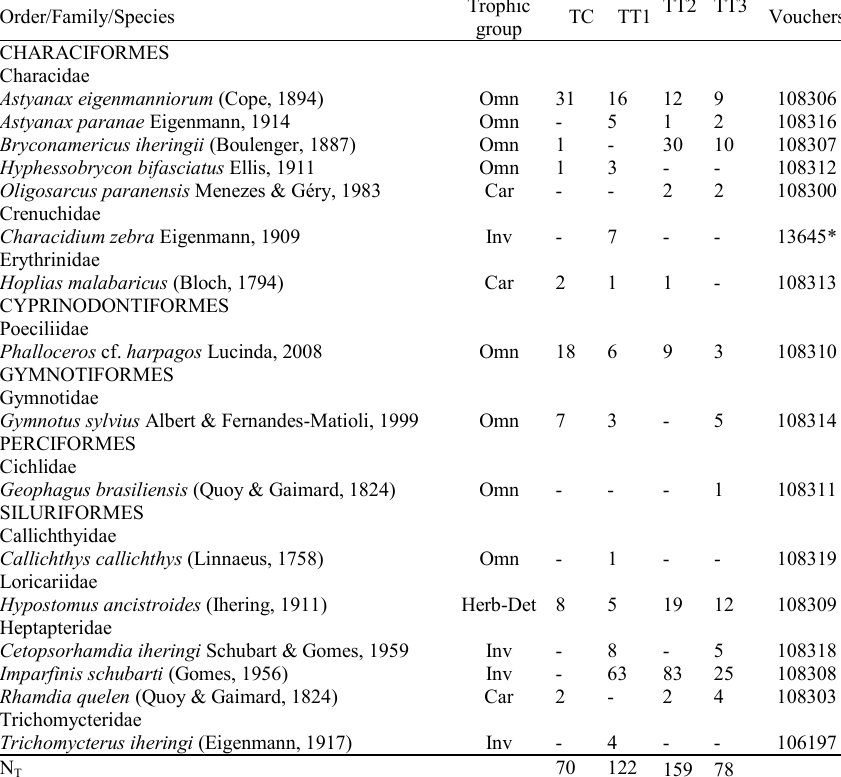
Table 1. Species list with respective abundances (N ) and trophic groups, herbivore-detritivore (Herb-Det), omnivore (Omn), T carnivore (Car) or invertivore (Inv), in the structurally complex streams (TT) and simplified stream (TC). Vouchers registered at the Museu de Zoologia, Universidade de São Paulo (MZUSP). Catalog numbers marked with na asterisk indicate vouchers registered at Departamento de Zoologia e Botânica, Universidade Estadual Paulista “Júlio de Mesquita Filho”, câmpus de São José do Rio Preto (DZSJRP). Order/Family/Species